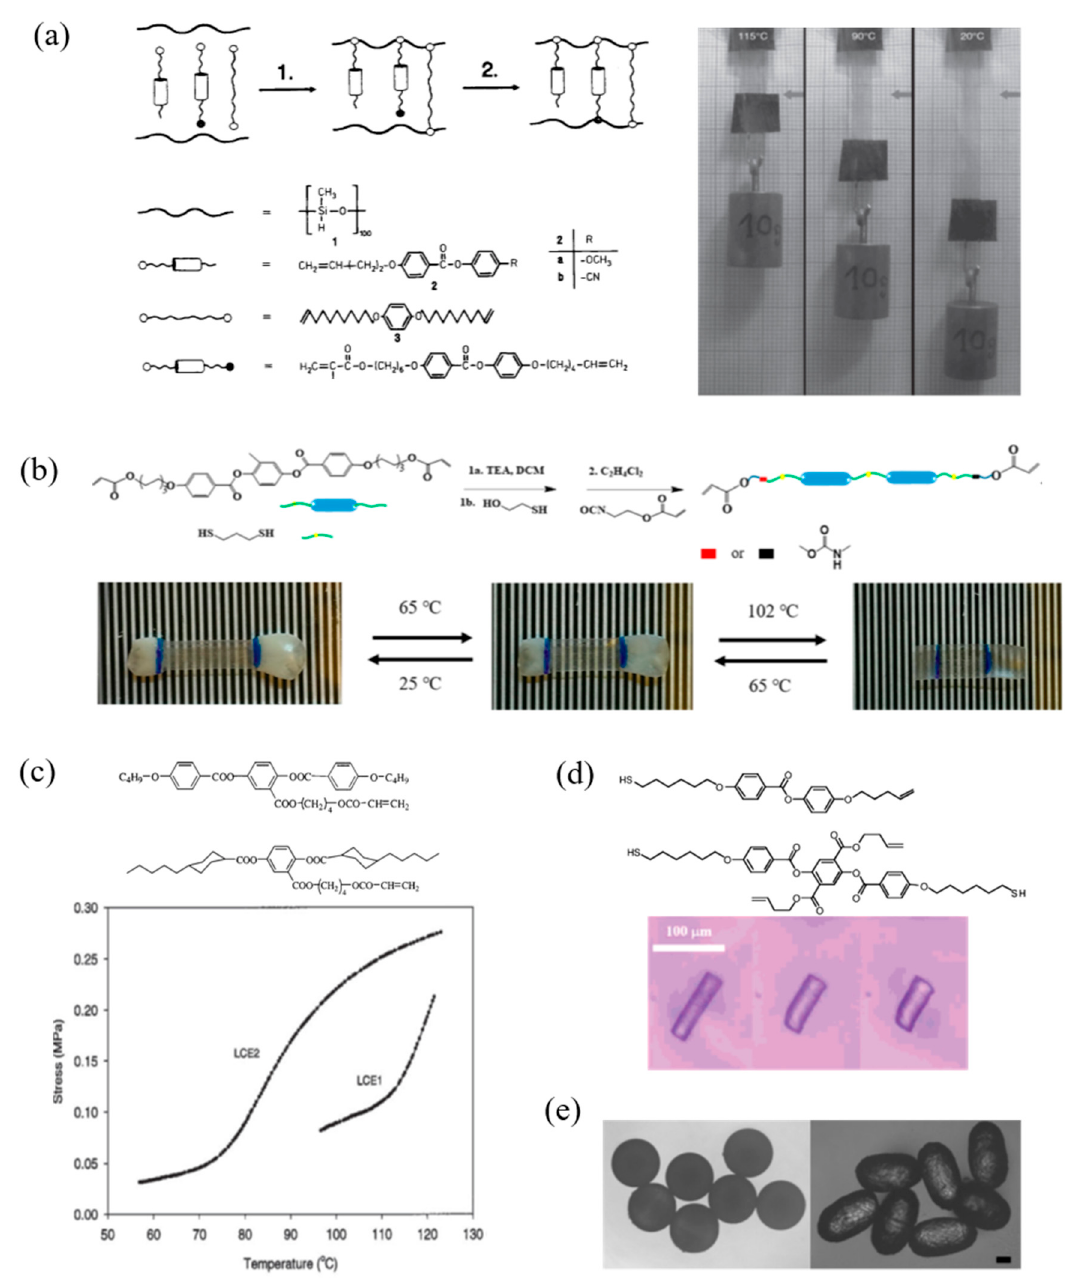
Figure 3. Contraction and expansion behaviors of LCPs along aligned orientation director. ( a ) Schematic illustration of a two-step crosslinking method and a reversible strain can lift up and put down a 10 g weight. Reproduced with permission from [16]. Copyright © 1991 WILEY-VCH. ( b ) The two-stage reversible strains were achieved by smectic A − nematic and nematic − isotropic phase transitions upon thermal cycling (from left to right). Reprinted with permission from [48]. Copyright (2018) American Chemical Society. ( c ) Iso-strain measurement on side-chain LCPs heating through the nematic to isotropic phase transition. Reprinted with permission from [27]. Copyright (2001) American Chemical Society. ( d ) An isolated pillar exhibits a contraction with the order of 35%. Reprinted with permission from [35]. Copyright (2006) American Chemical Society. ( e ) LC-particles possess reversible changes from spherical to cigar-like. Reproduced with permission from [36]. Copyright © 2009 WILEY-VCH.